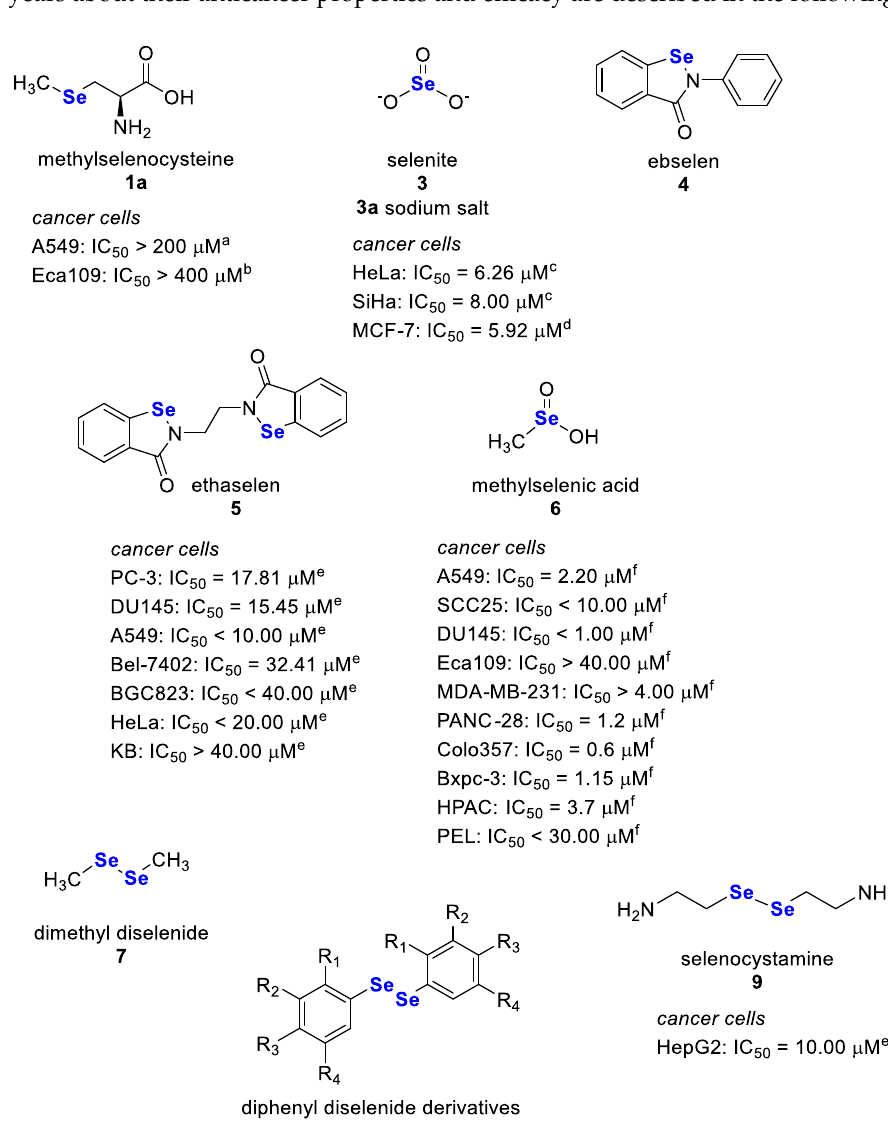
Figure 4. Chemical structures of representative inorganic and organic selenium compounds 1 - 8 dis- cussed in this review. Data from: a [55], b [56], c [57], d [58], e [39], f [59], g [60], h [61], i [52]. 3.1. Selenites and Sodium Selenite Selenite 3 and its sodium salt, sodium selenite 3a , represent the most investigated inorganic Se-containing compounds. These molecules have been shown to possess anti- cancer activity in several cancer cell lines, including prostate, breast, lung, hepatoma, bladder, and osteosarcoma [52]. Recently, the anticancer effects of sodium selenite 3a were also displayed in cervical cancer cells with IC 50 values ranging from 6.26 to 8.00 μM and